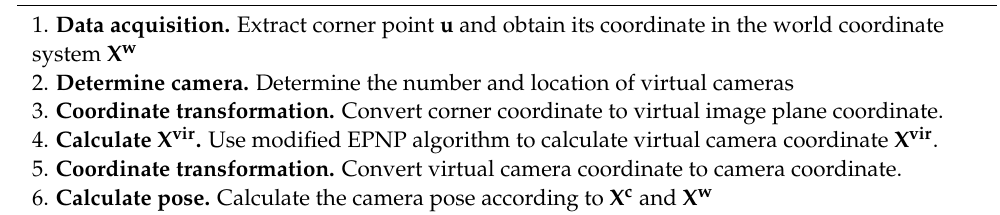
Algorithm 1. Logic of omnidirectional camera pose estimation algorithms.